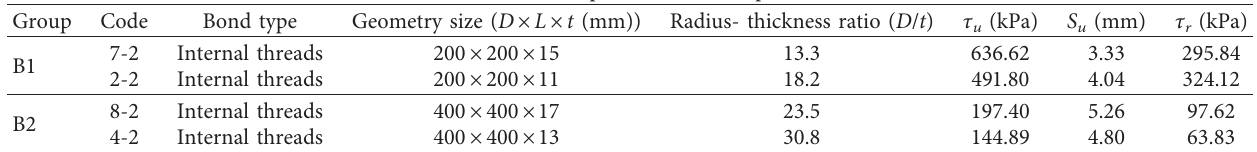
Table 7: Test results of specimens of Groups B-1 and